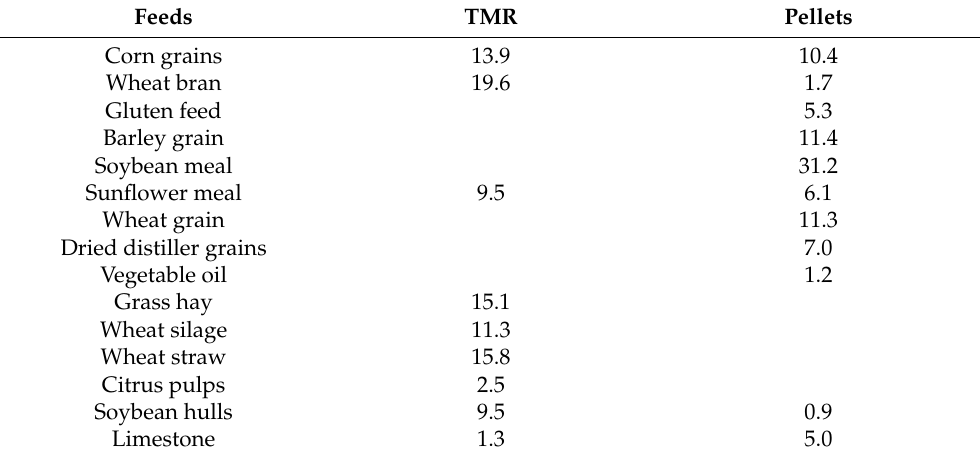
Table 1. Composition of the total mixed ration (TMR) and pellets (expressed as % DM unless otherwise